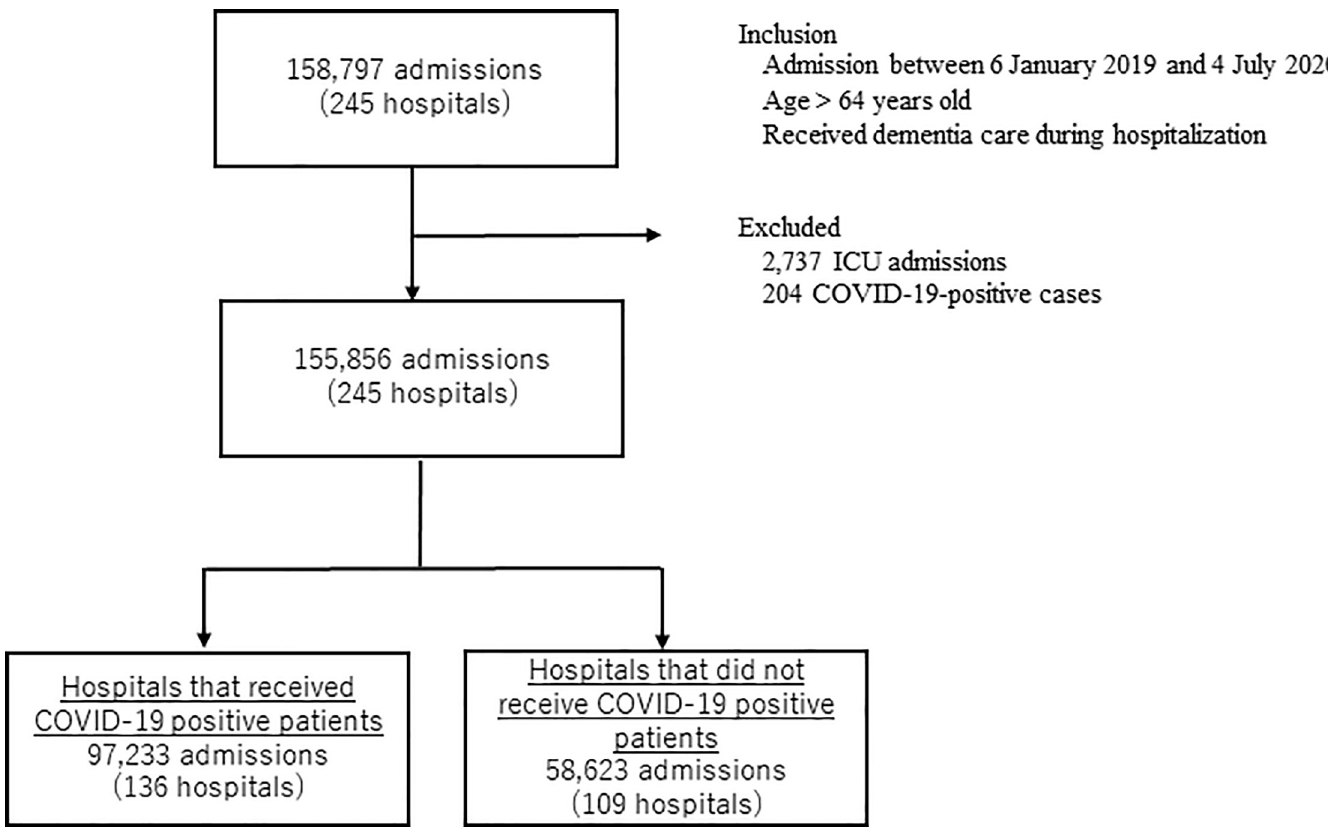
Fig 1. Flowchart depicting patient progression in this study based on the eligibility and exclusion